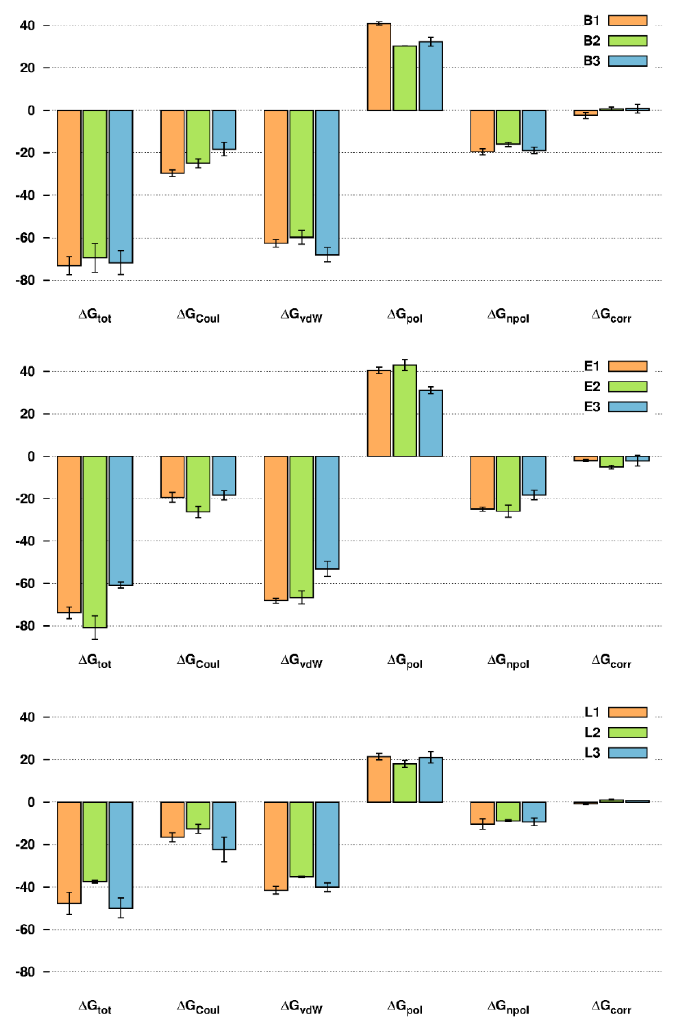
Figure 7. Results of the Molecular Mechanics Generalized Born Surface Area (MM-GBSA) analysis for Compounds B1–3 (top panel), E1–3 (central panel), and L1–3 (bottom panel). The left bars report the total free energy of binding ( ∆ G tot ). The electrostatic, van der Waals, polarization, nonpolar solvent–solute interaction, andtotalcorrectionscontributions( ∆ G Coul , ∆ G vdW , ∆ G pol , ∆ G npol , and ∆ G corr , respectively) are also